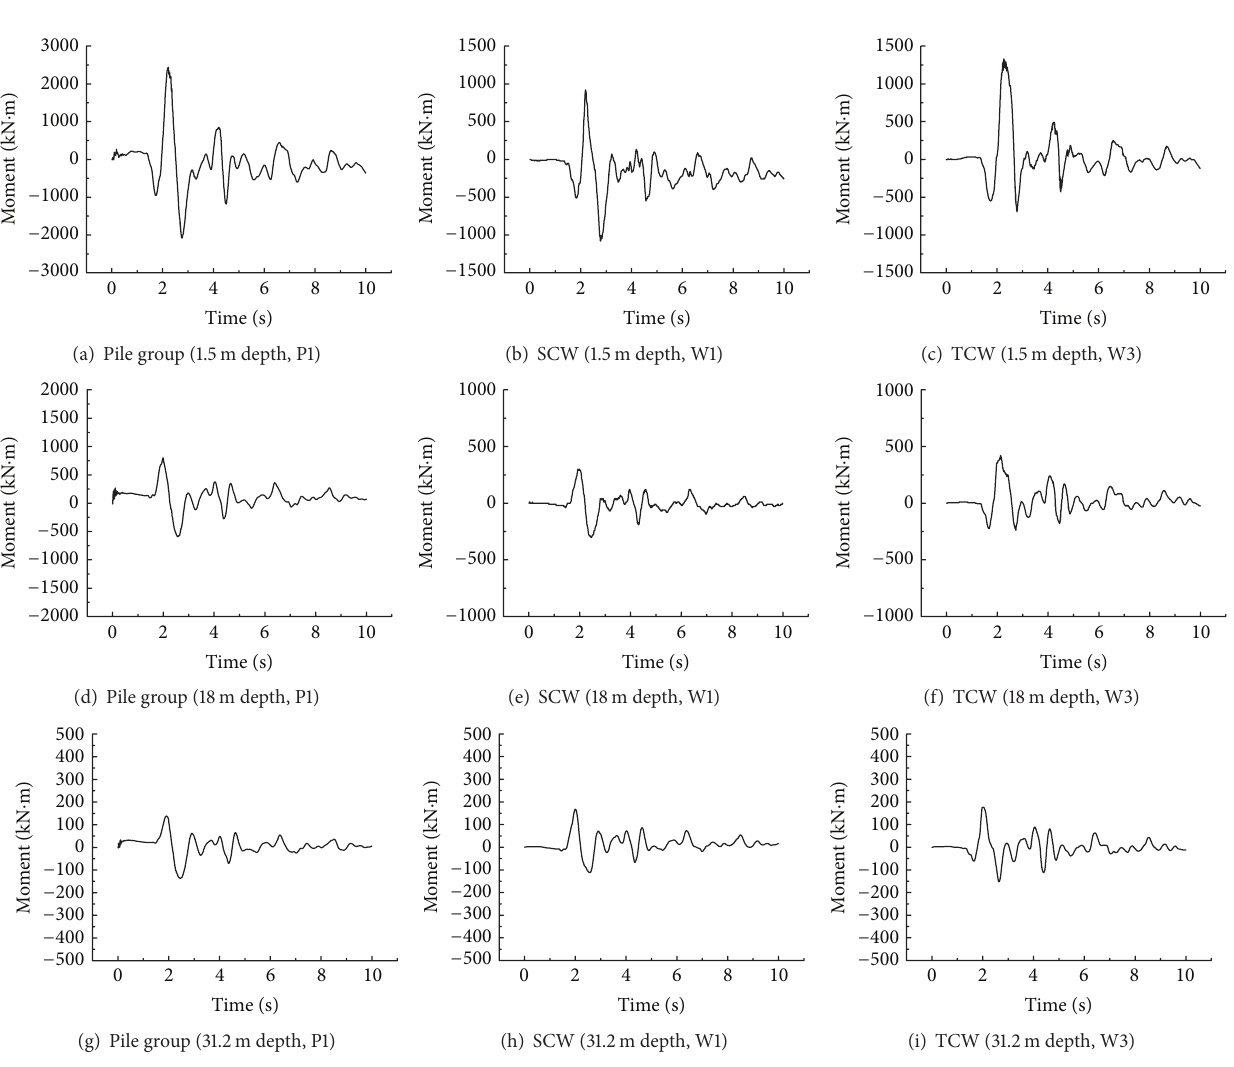
Figure 18: Bending moment at different depth for three models.